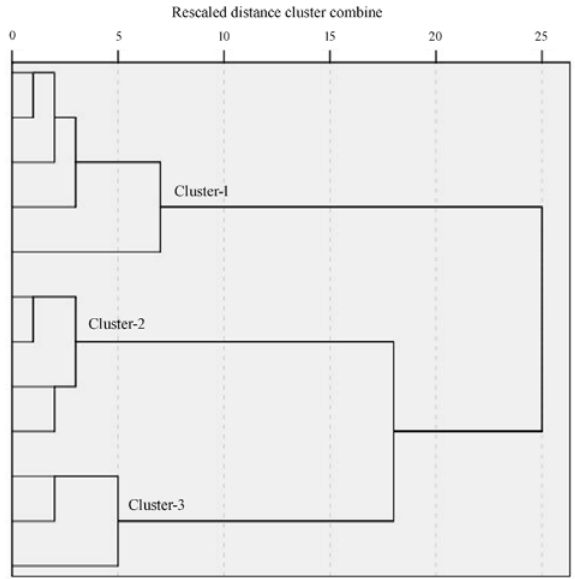
Fig. 4: Dendrogram showing pattern of objects homogeneity